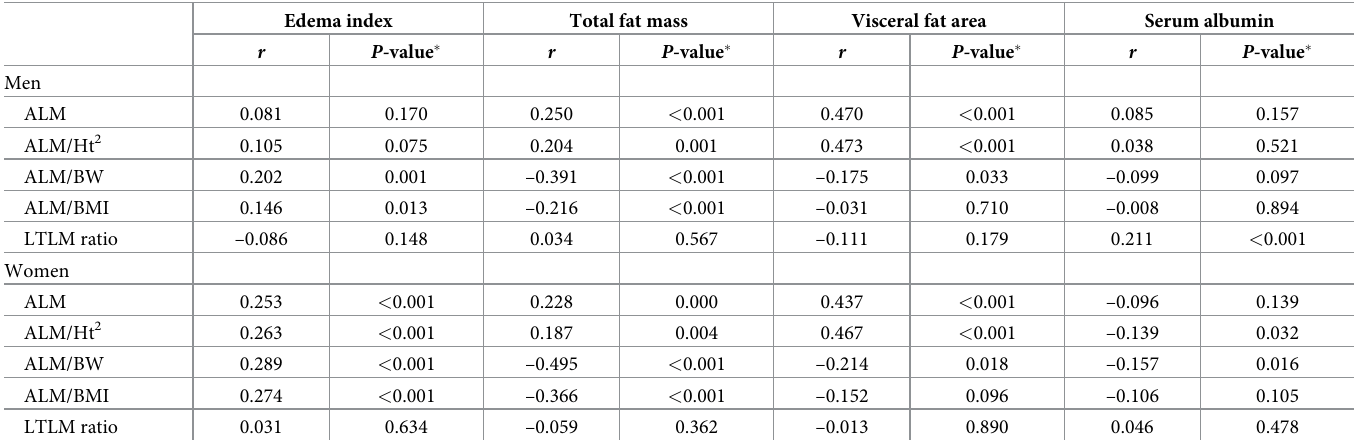
Table 2. Correlation between various indices and clinical variables in PD